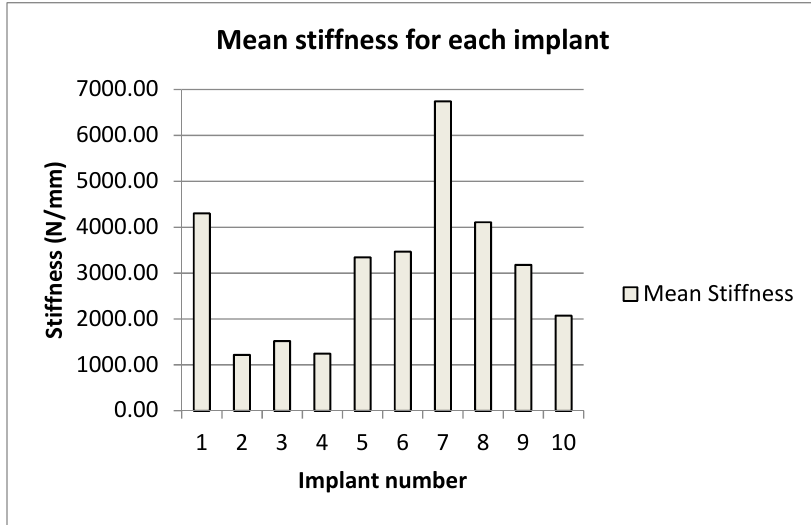
Figure 4. Mean axial stiffness compared to mean load for each implant.